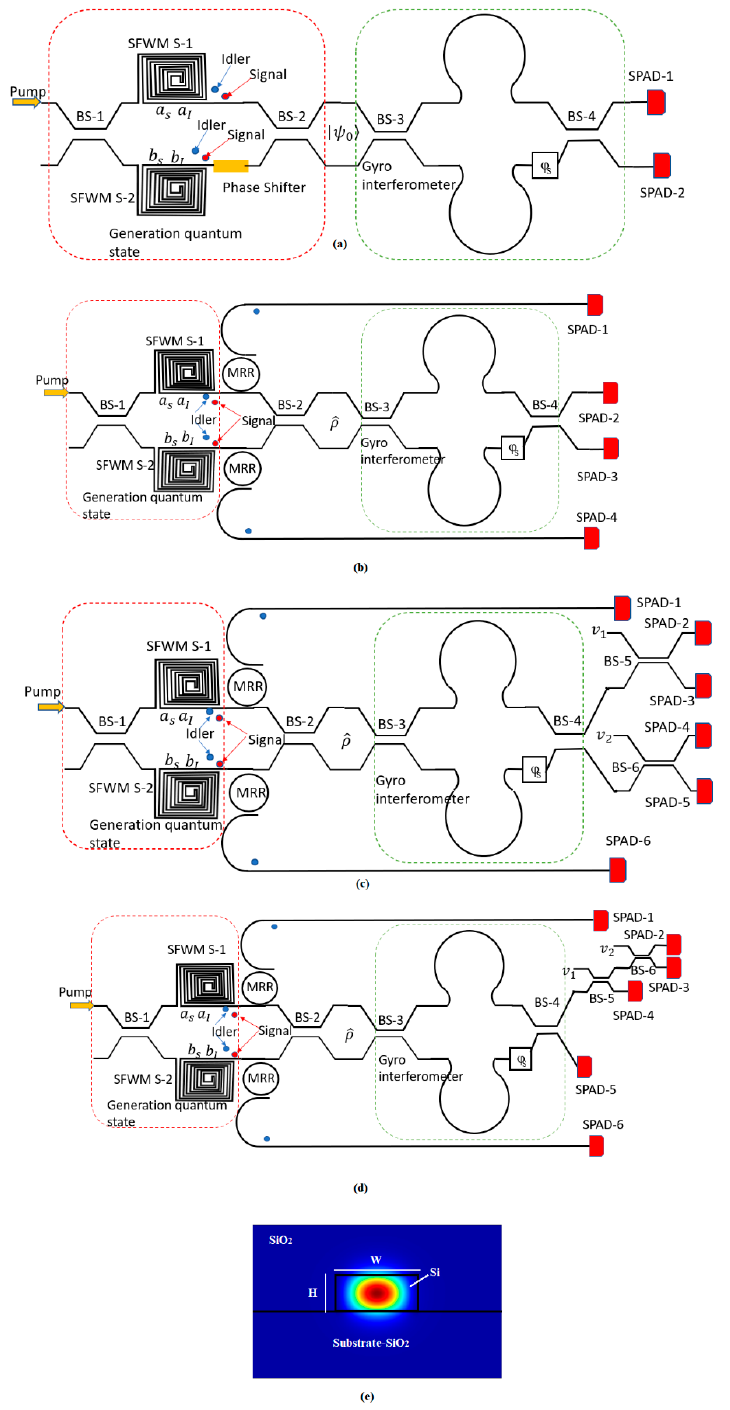
Figure 1. Schematic top view of proposed quantum optical gyro architectures with 2× ( a – b ), and 4× ( c – d ) advantage; and, ( e ) Poynting vector for TE mode at 1550 nm, assuming 𝐻 = 220 nm and 𝑊 = 500 nm.